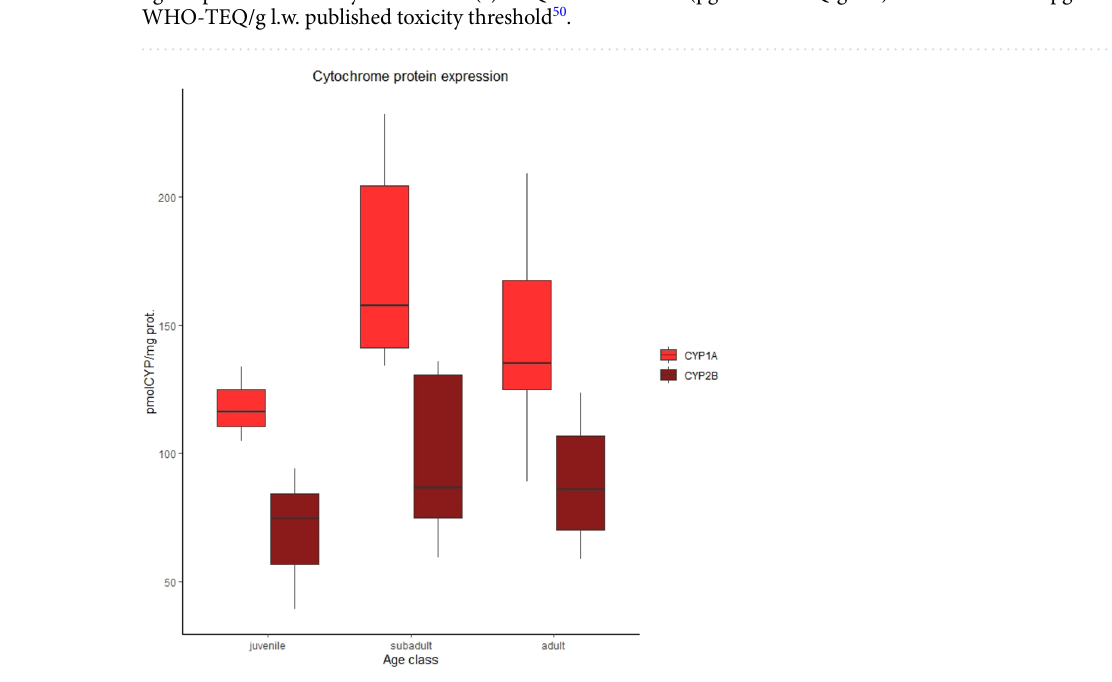
PBDEs concentrations.